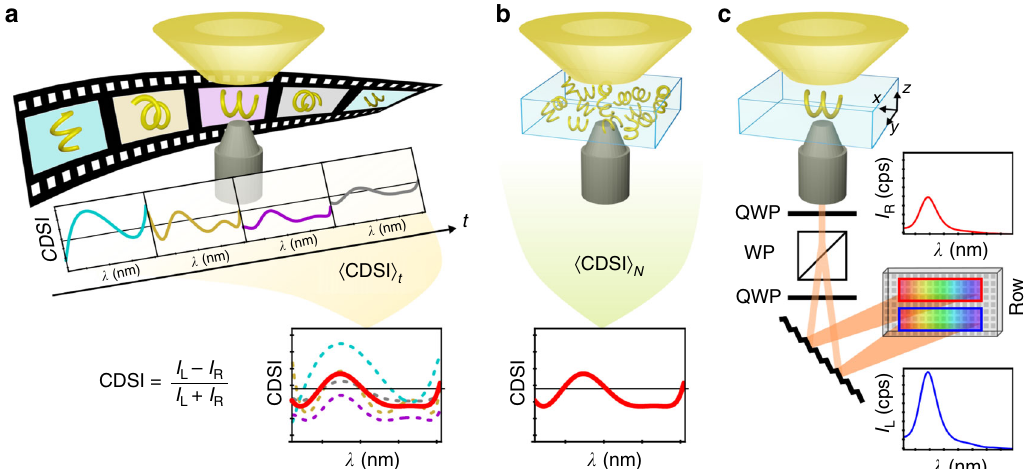
Fig. 1 Single particle chiroptical spectroscopy versus ensemble spectroscopy. a A time-series experiment acquires snapshots of the circular differential scattering intensity (CDSI) at arbitrary instants of time at which the particle has a fi xed orientation in space and which yields the time-averaged 〈 CDSI 〉 t . b An ensemble-average 〈 CDSI 〉 N originates from N individual particles, which are isotropically oriented in solution. c Schematic of the setup, which utilizes a dark- fi eld condenser for directing the incident light onto the sample and a microscope objective to collect the light scattered off the particle. The objective is followed by polarization optics, consisting of two quarter-waveplates (QWP) and a Wollaston prism (WP) to simultaneously acquire spectra of scattered left- and right-circularly polarized light (LCP and RCP) on a single detector